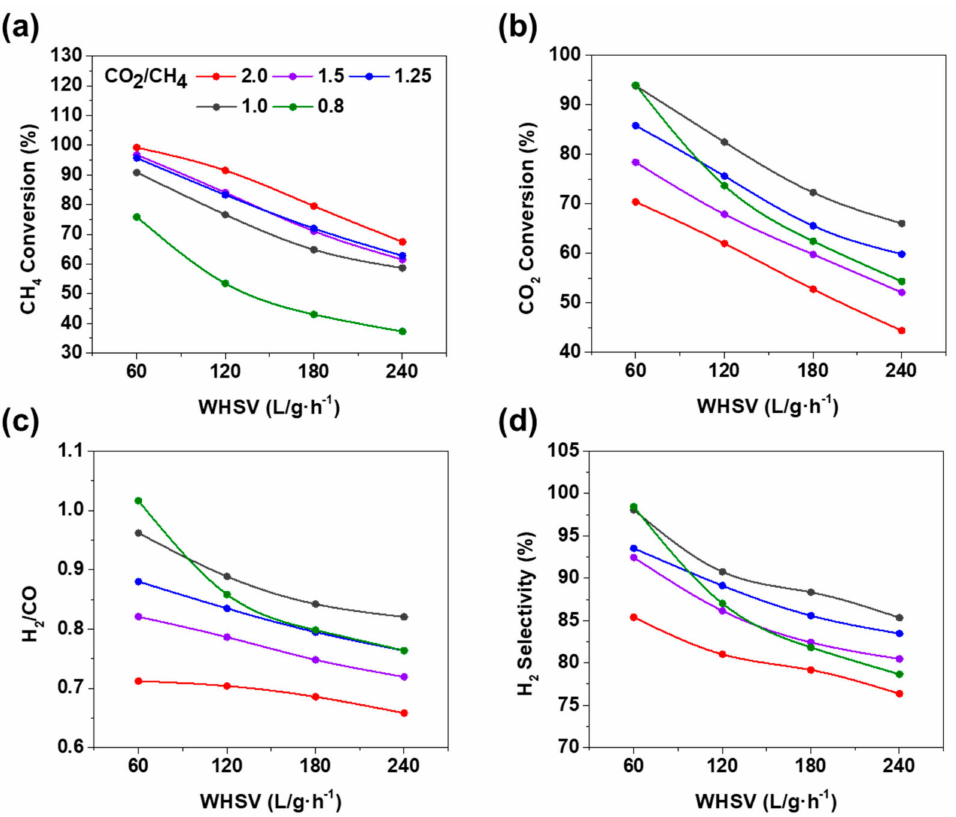
Figure 3. Influences of space velocity (60,120,180 and 240 L/g · h − 1 ) on ( a ) the CH 4 conversion, ( b ) CO 2 conversion, ( c ) H 2 /CO, ( d ) H 2 selectivity; T = 800 ◦ C, N 2 = 40 % v / v of total